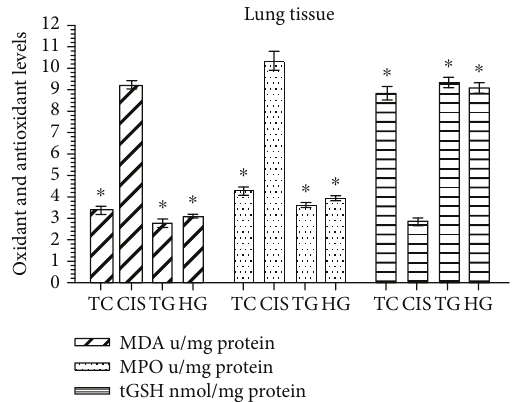
Figure 2: MDA, MPO and tGSH values in lung tissues of the study groups. TC, TG and HG groups were compared with the CIS group ( n = 6 , ∗ P < 0 0001 ).